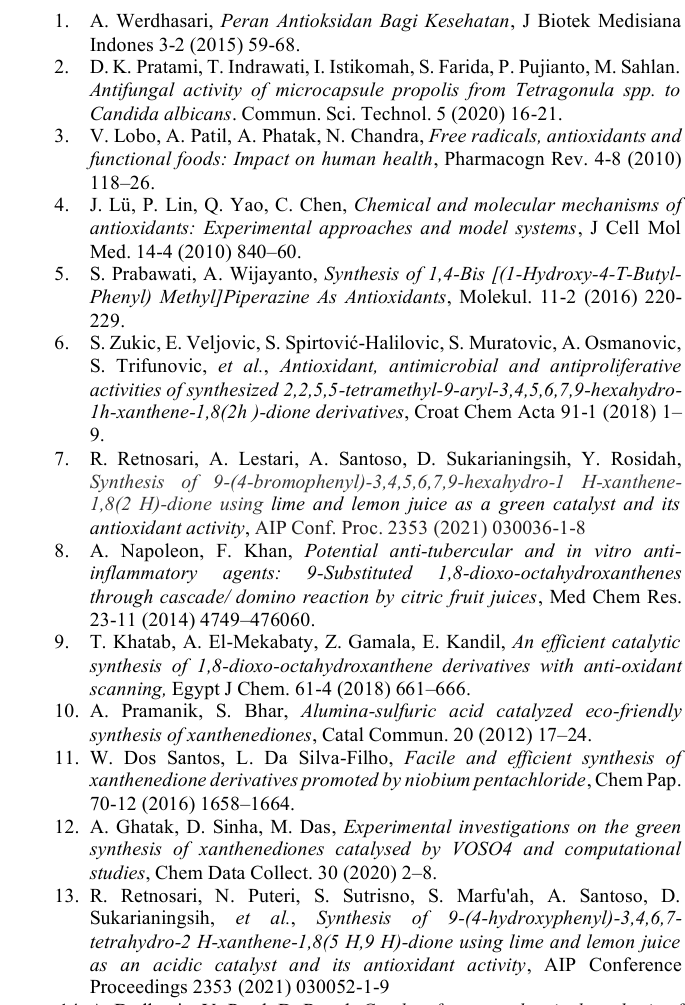
Fig. 5. Inhibition Percentage toward Compound 1 Concentration Variation